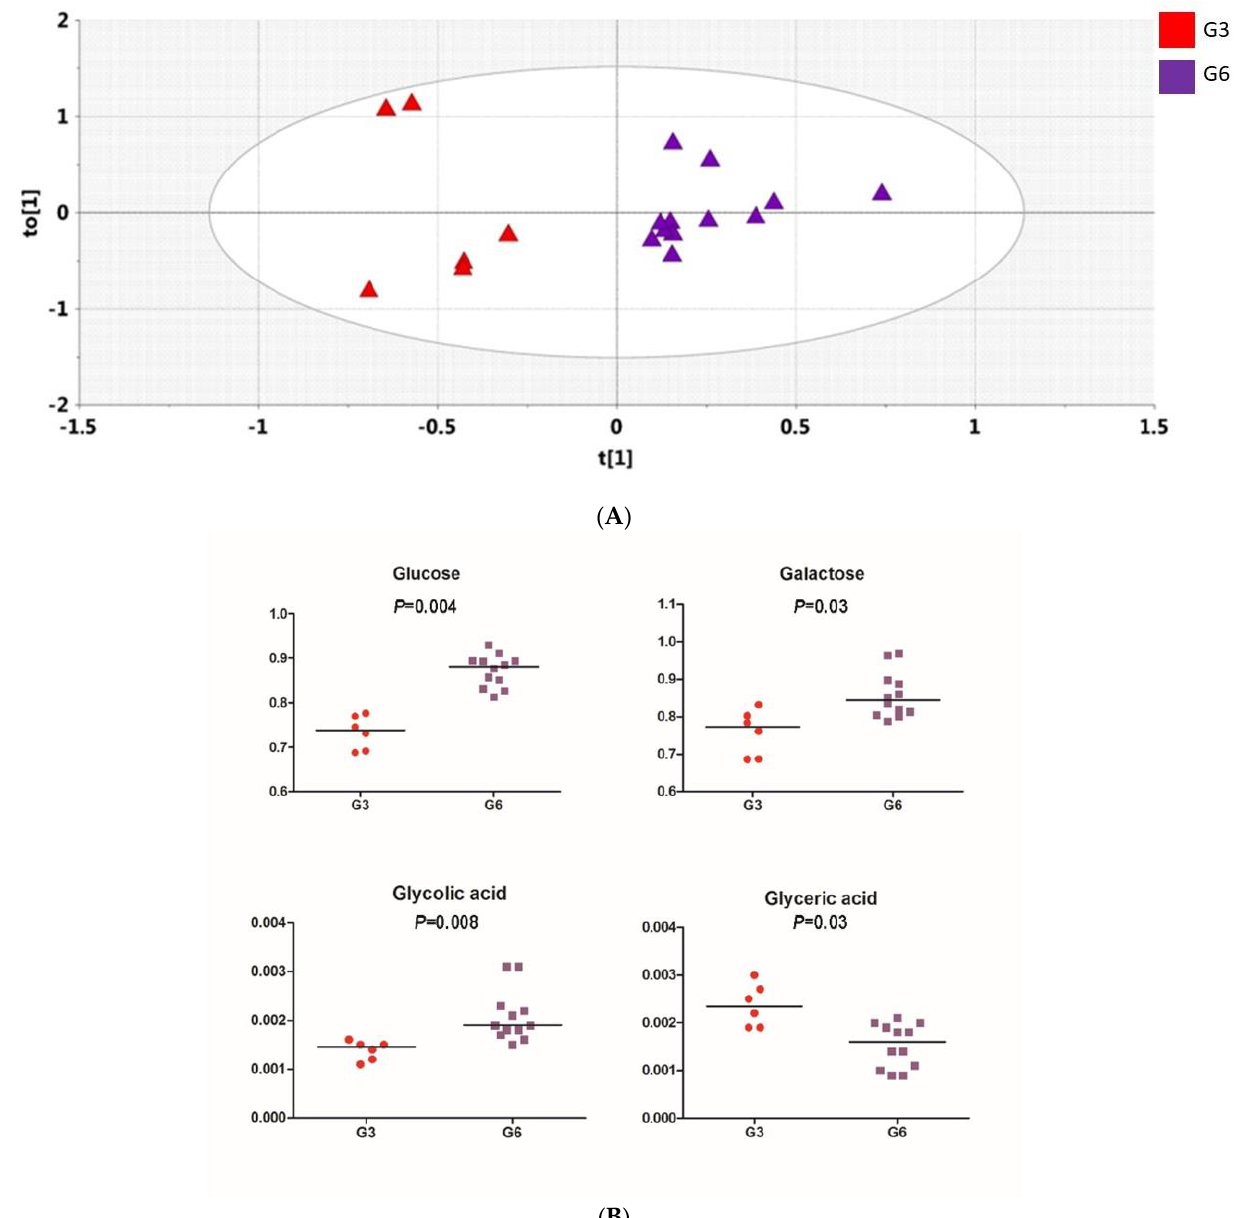
Figure 6. ( A ) OPLS-DA scores plot for plasma showing separation of subgroup G3 ( n = 3; red) vs. subgroup G6 ( n = 6; purple). G3 showed UV resistance on Day 30 and Day 60; G6 showed UV resistance on Day 30, but not Day 60. The difference is still apparent after the final washout period (Day 60). Data presented as duplicate analyses. ( B ) Univariate analysis (Mann–Whitney) for plasma metabolites after the final washout period (Day 60) showing separation of subgroup G3 ( n = 3; red) vs. subgroup G6 ( n = 6; purple). Data presented as duplicate analyses; p -values are Bonferroni corrected.